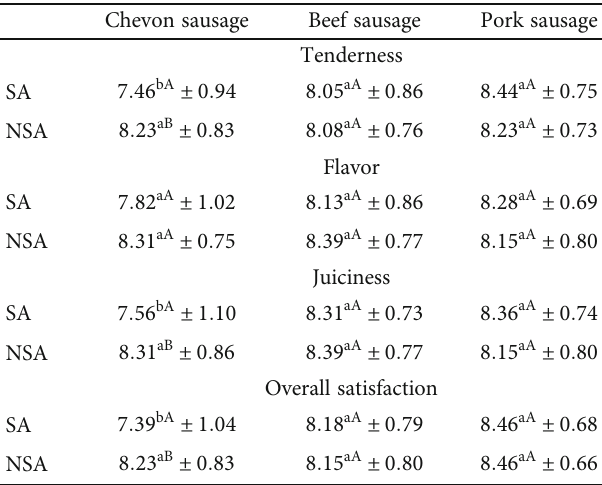
Table 1: Proximate composition of beef, chevon, and pork sausages.